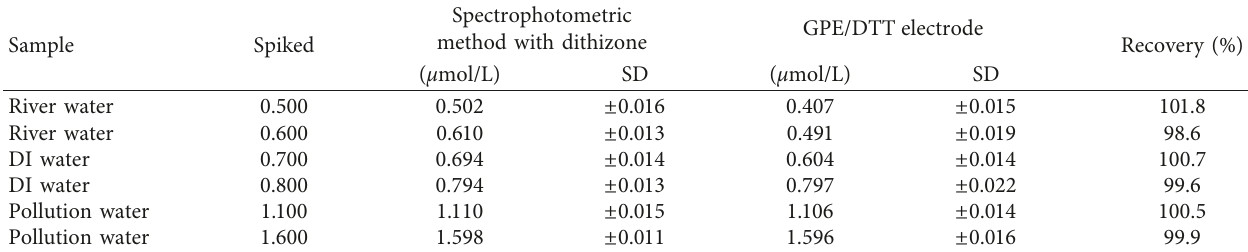
Table 3: Recovery of the proposed GPE/COF TFPB-TZT electrode for the determination of Mercury ions in real water samples compared with the spectrophotometric method utilizing